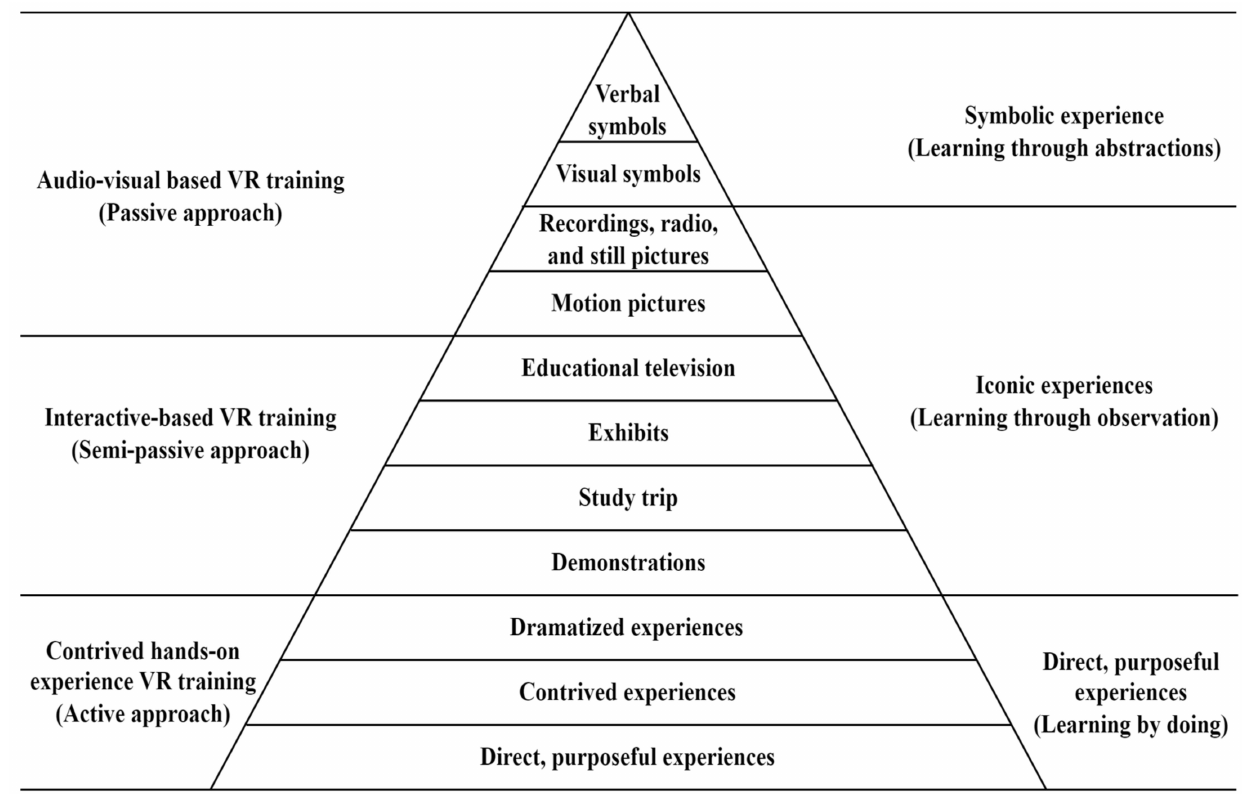
Figure 1. Developmental approach of VR construction training scenarios based on Edgar Dale’s cone of